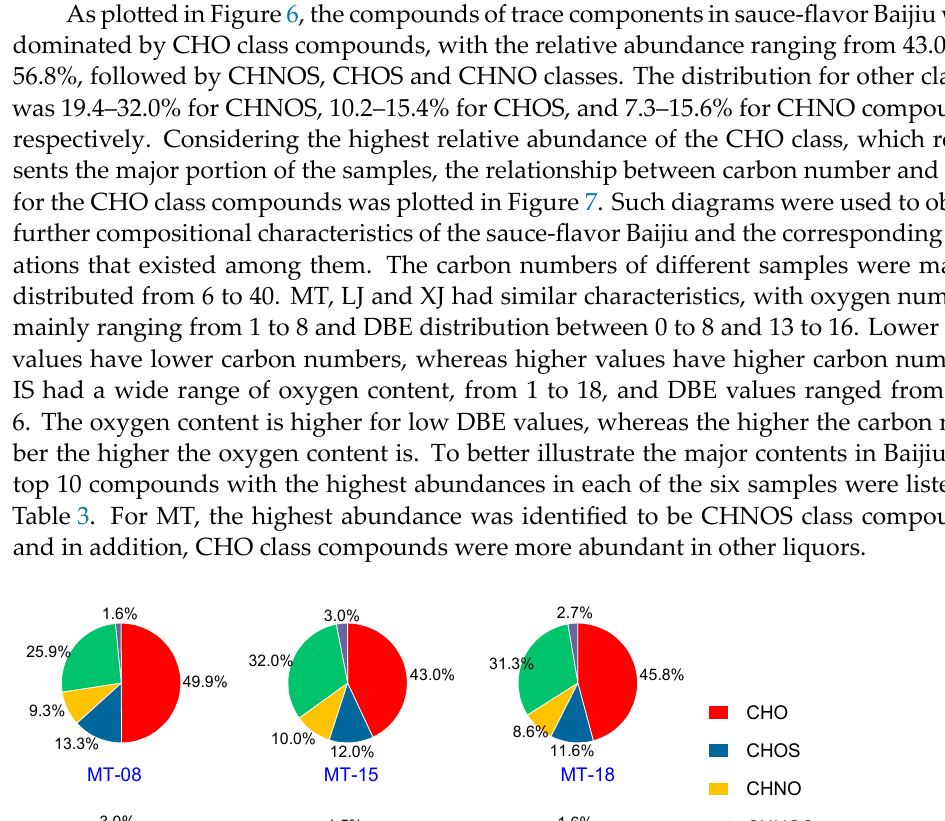
Figure 5. Bar diagrams showing the contribution of major compound categories in the different Baijiu samples revealed by the combination of ESI+ and ESI − mass spectrometry analysis.